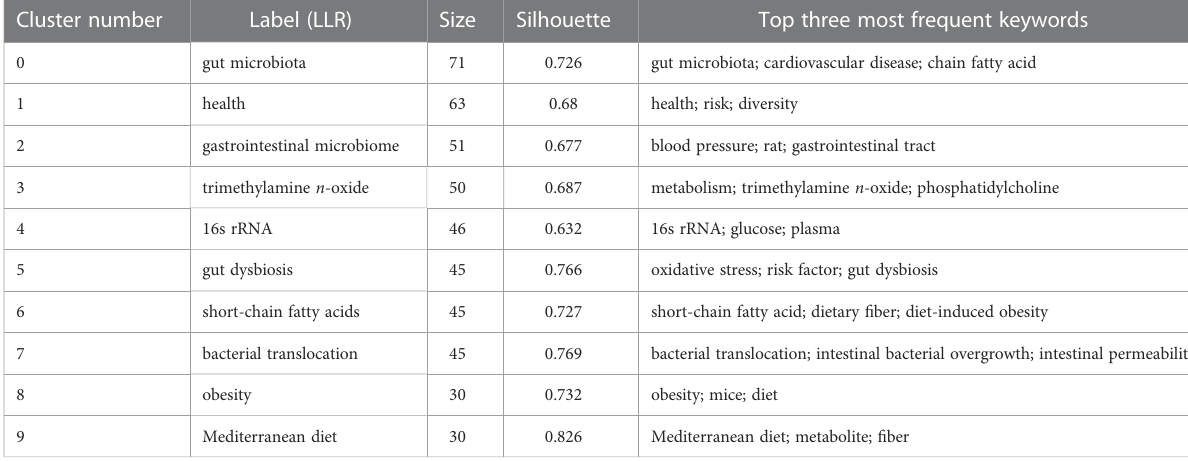
TABLE 8 The main clusters of keywords in studies of the GM in CVD. Cluster number Label (LLR) Size Silhouette Top three most frequent keywords